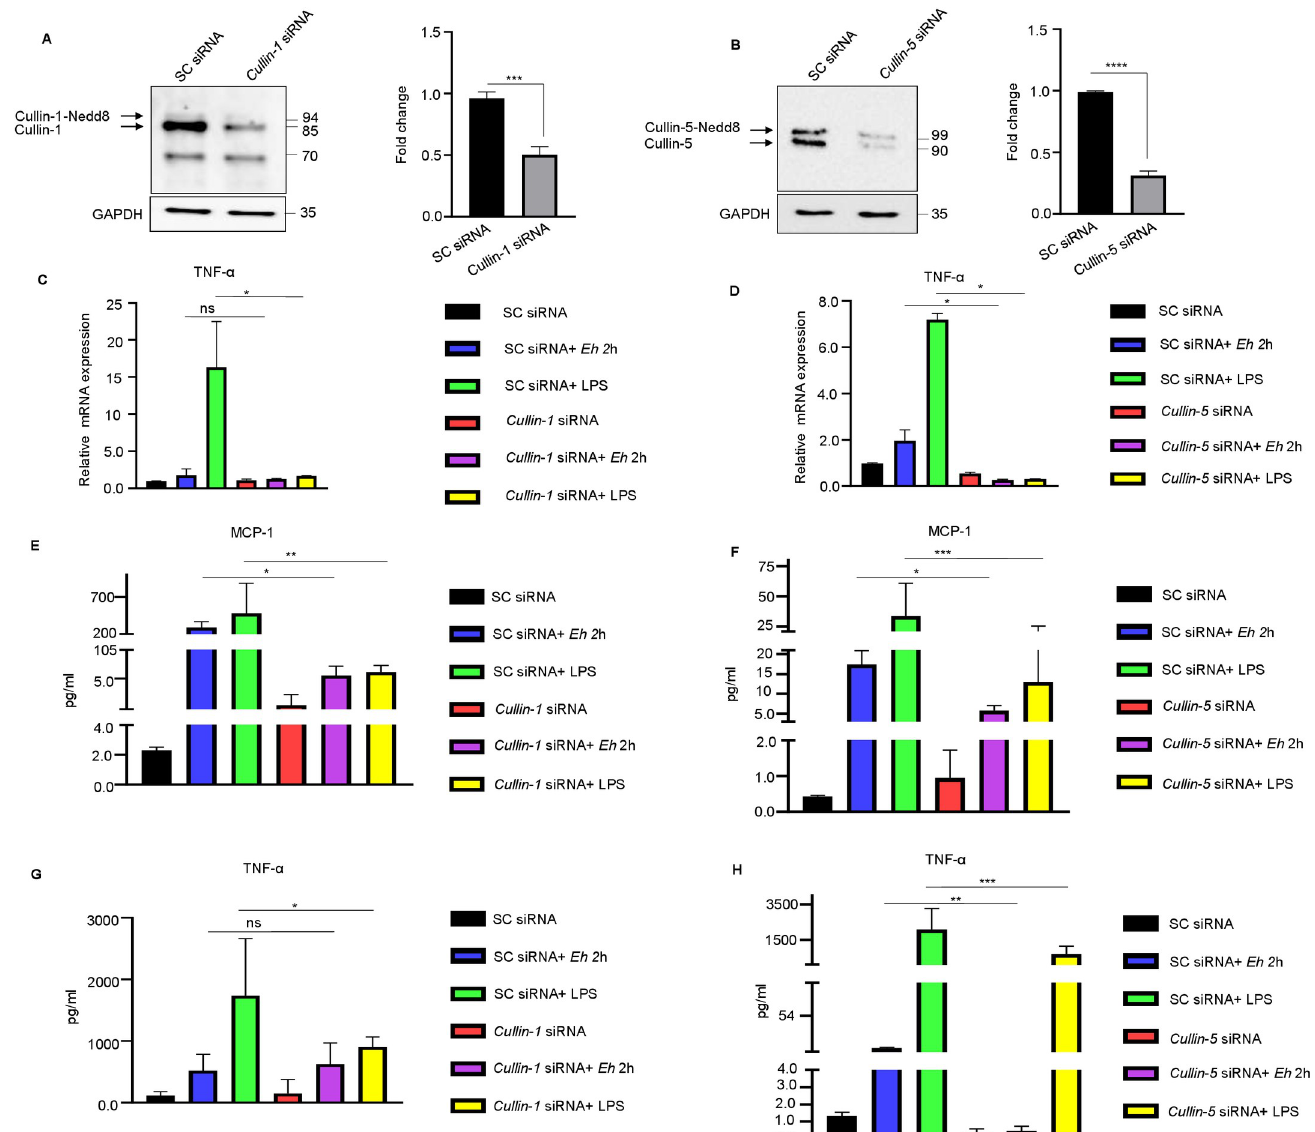
Fig 7. Silencing cullin-1/5 decreased mRNA and protein expression of NF- κ B dependent cytokines. (A, B) THP-1 cells were transfected with scrambled control (SC siRNA), 100nM of cullin-1 siRNA (A) , and 100nM of cullin-5 siRNA (B) , respectively. After 72h, transfected cells were washed and lysed and immunoblotted against the indicated antibody to verify silencing. ( C-D) THP-1 cells silenced for cullin-1/5 by siRNA were stimulated with Eh for 2h and TNF- α mRNA expression was measured using real-time PCR. Post silencing of cullin-1/5 genes, cells were incubated with Eh for 2h and pro-inflammatory cytokines levels measured using human cytokine array pro-inflammatory focused 15-plex discovery assay. LPS was used as a positive control for the experiment. Silencing of cullin-1/5 downregulated MCP-1 (E, F) and TNF- α ( G, H) in response to LPS stimulation. Data are representative of three independent experiments. Bars represent mean ± SEM. � P < 0.05, �� P < 0.01, ��� P <